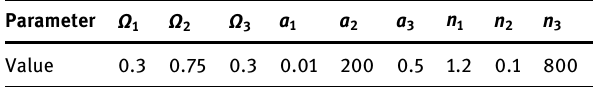
Table 3: Parameters of the